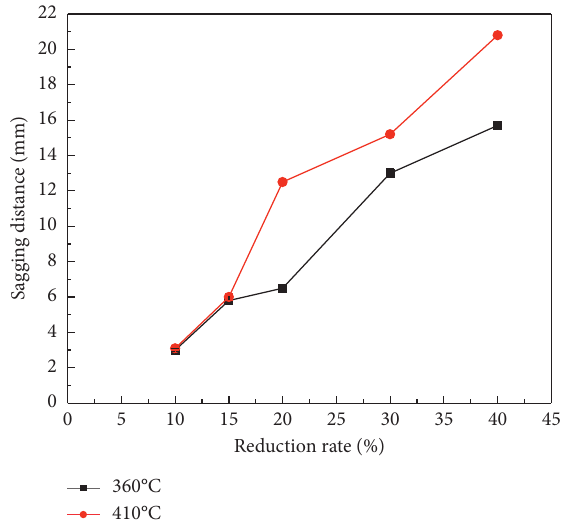
Figure 9: Sagging distance as a function of the rate of reduction after brazing.